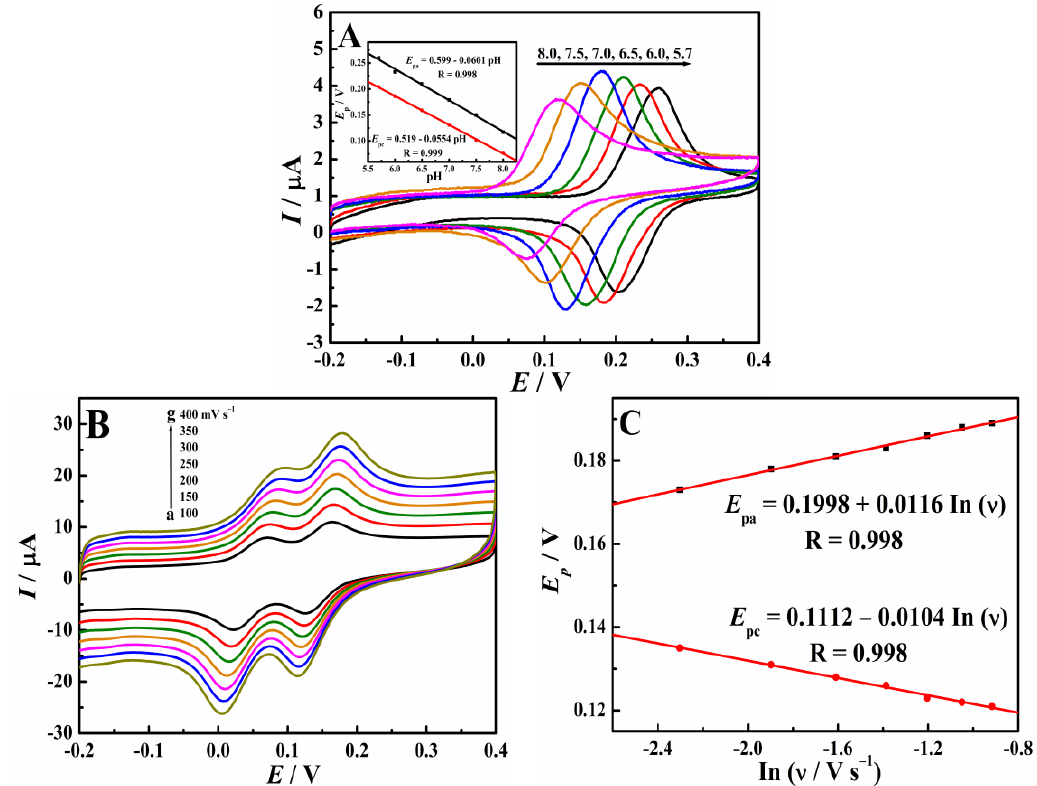
Figure 7. ( A ) CV behaviors of 100 µM DA on Cu-TCPP/graphene/GCE in PBS with different pH values, inset: E pa -pH plot; ( B ) CV behaviors of 100 µM DA on Cu-TCPP/graphene/GCE in pH 7.0 PBS with different scan rates; ( C ) plots of E p -ln ( ν ).